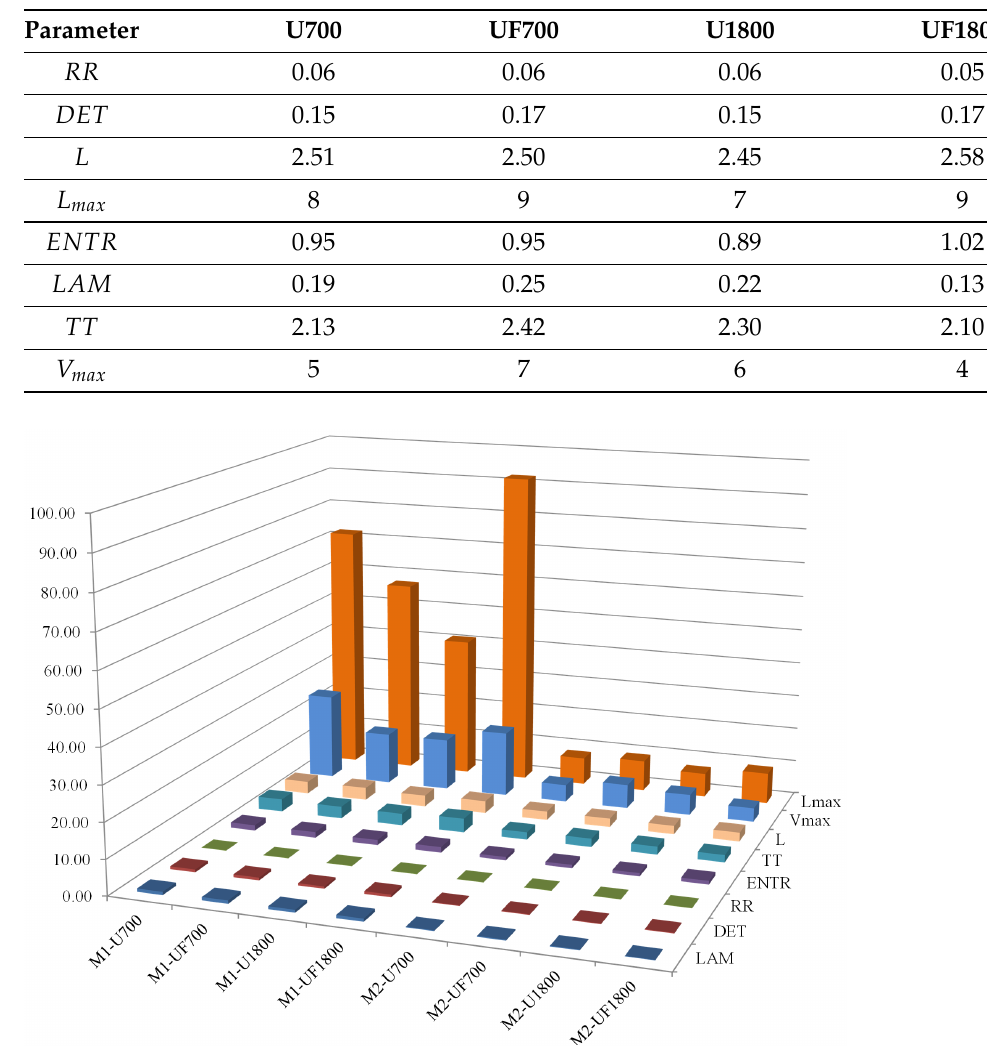
Figure 18. Quantification analysis of the experimental data: SDEMDI (M1); PSEMDI